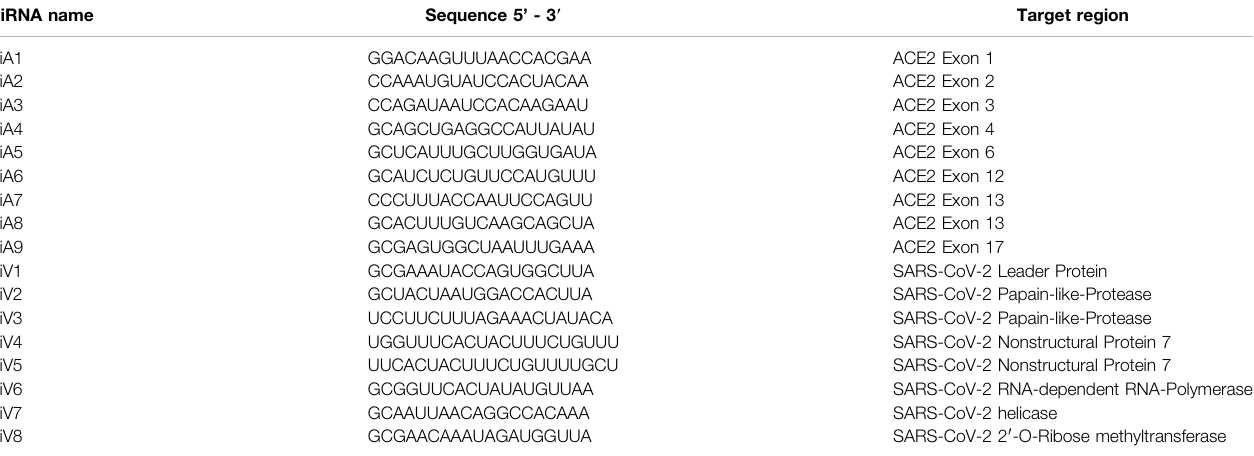
TABLE 1 | siRNAs used for lipofection. siRNAs containing a 3 ’ dTdT overhang were ordered from Ambion (LIFE